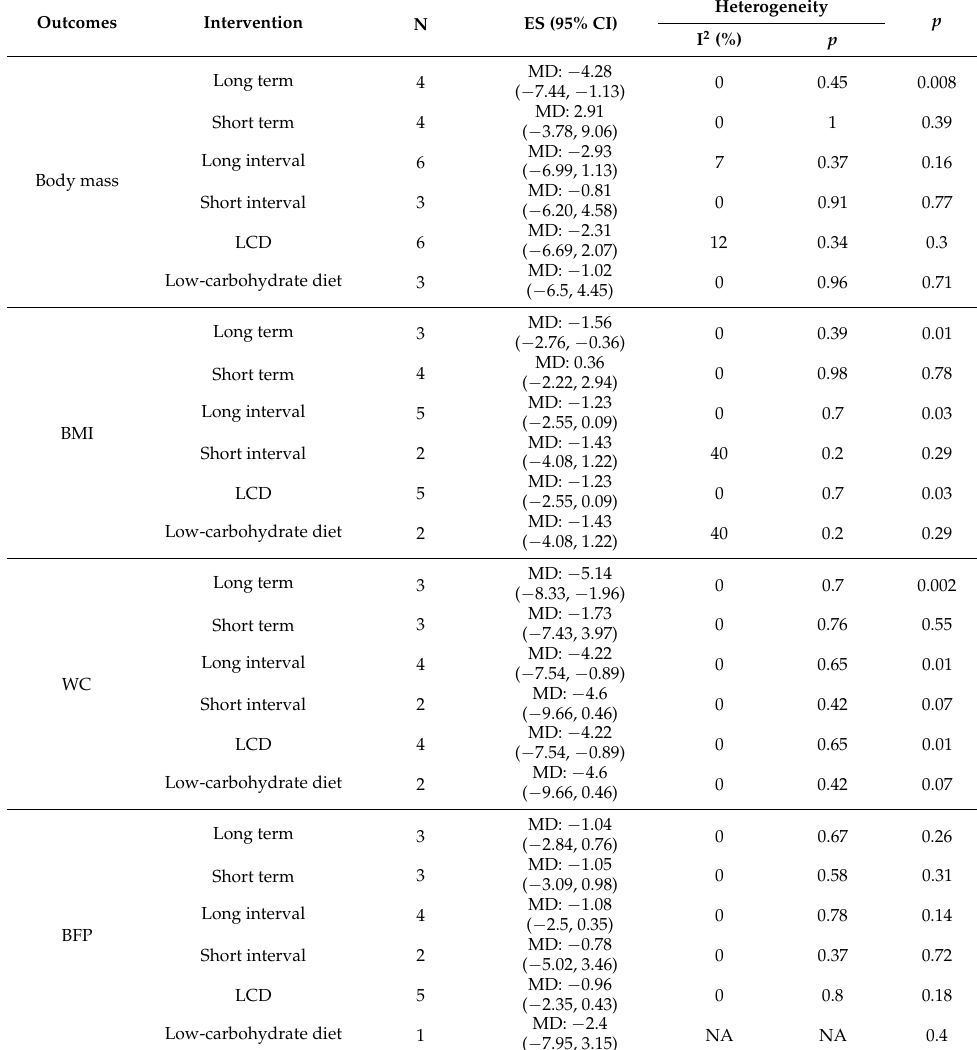
Table 4. Subgroup analysis for HIIT + fasting in overweight and obese